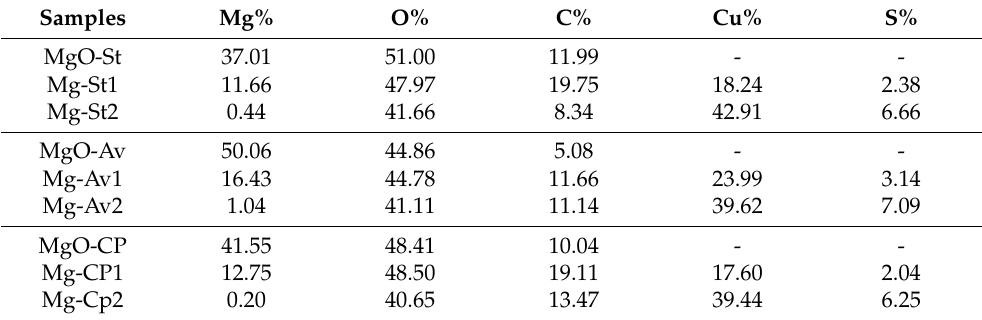
Table 5. Compositional chemical analysis data by EDS (% element) for the samples before and after adsorption at lowest (Mg-St1, Mg-CP1, and Mg-Av1) and highest concentrations (Mg-St2, Mg-CP2, and